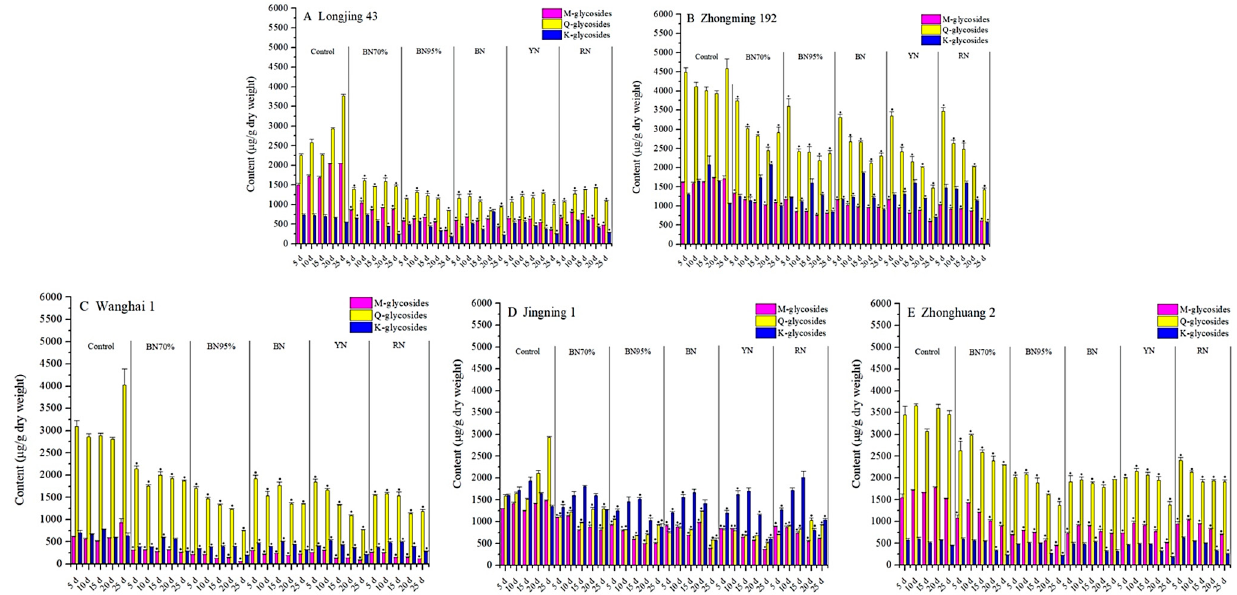
Figure 4. Impacts of different shade treatments on the contents of flavonol glycoside groups classified by aglycone. M-glycosides: myricetin glycosides; Q-glycosides: quercetin glycosides; K-glycosides: kaempferol glycosides. For the same tea cultivars harvested on the same day, data annotated with * were significantly different from the corresponding CK ( p < 0.05). Significant difference analysis was carried out using the TTEST function of Microsoft Excel for Mac (version 16.54, Microsoft Corporation, Redmond, WA, USA).